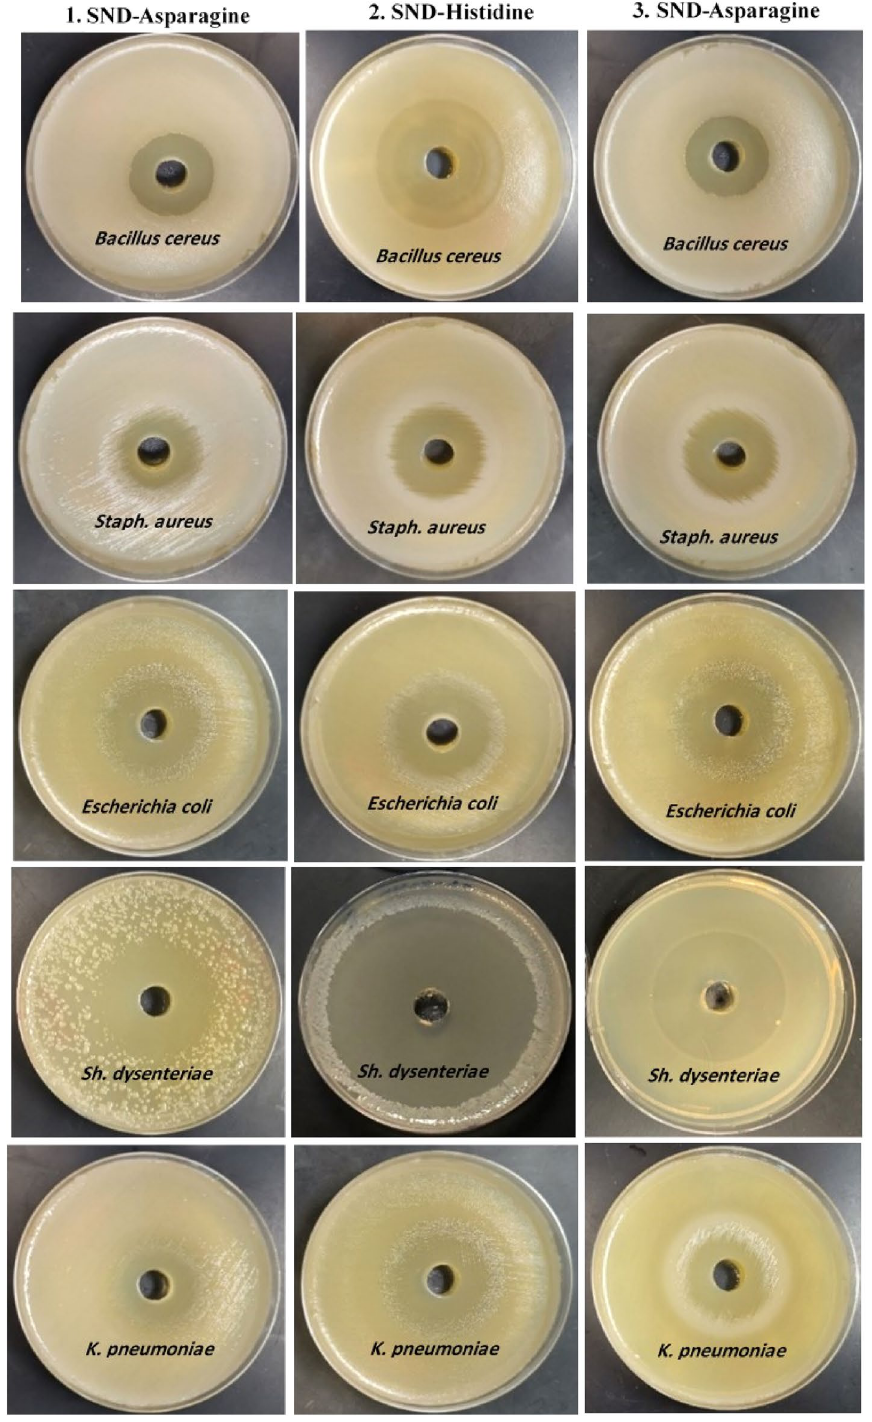
Figure 11. Antimicrobial activity of the surfactants in comparison to traditional antibiotics against food-borne pathogenic bacteria indicated by clear zone diameter